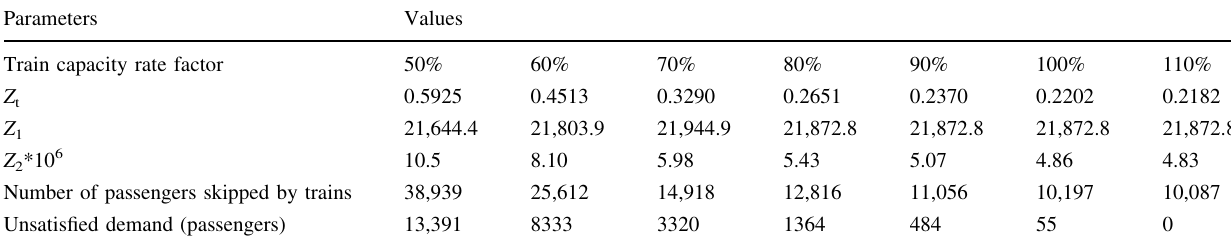
Number of passengers skipped by trains